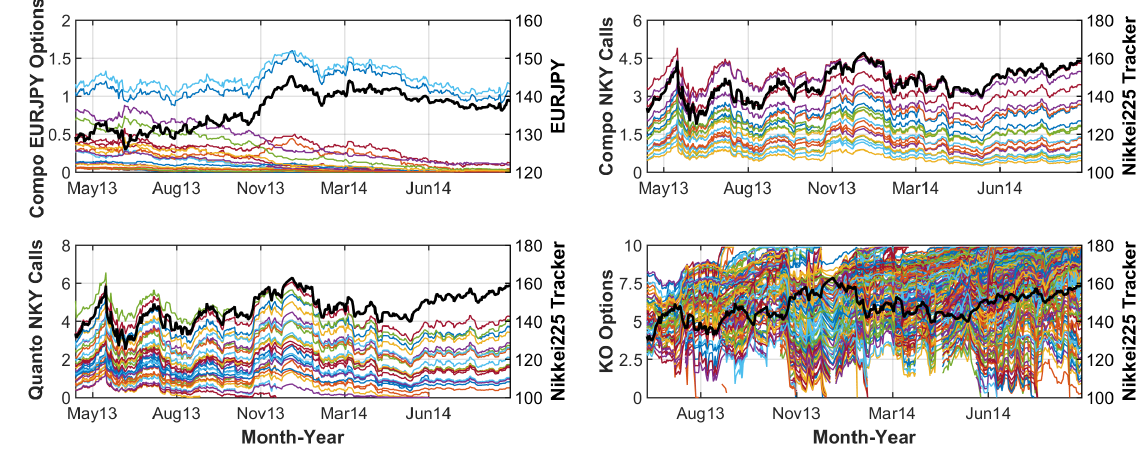
Figure 4. Top: Société Générale’s compo EURJPY options call prices ( left ) and compo Nikkei 225 call prices together with the Nikkei 225 tracker prices ( right ). Bottom left: Société Générale’s quanto call prices and the Nikkei 225 tracker price. Bottom right: Société Générale’s KO option prices and the Nikkei 225 tracker price. Vanilla (compo & quanto) contracts covering the period 16 April 2013 to 15 September 2014, KO options 19 June 2013 to 15 September